Question: What visual encoding does this figure use to show its data?
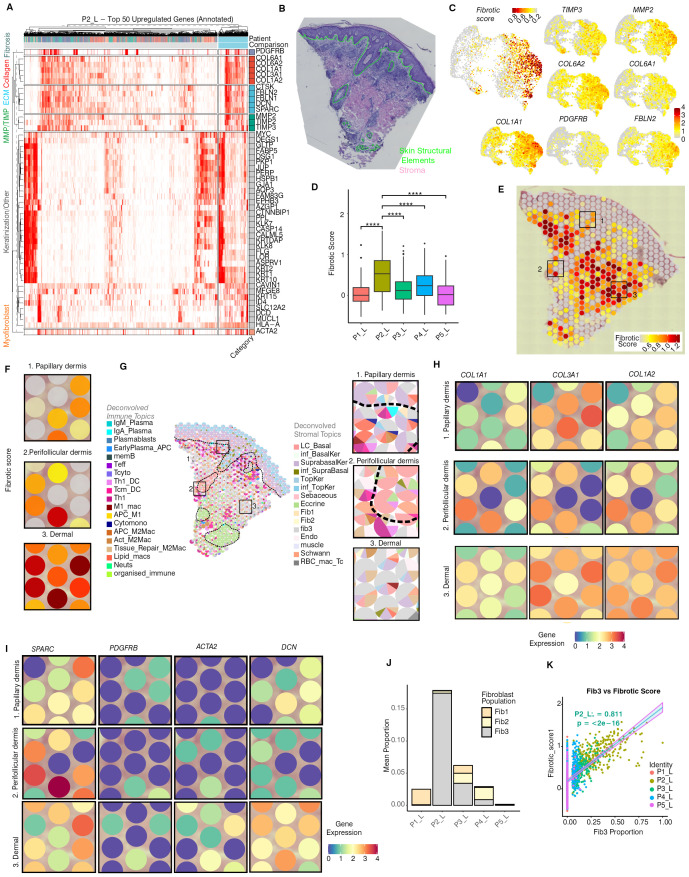
Answer: heatmap